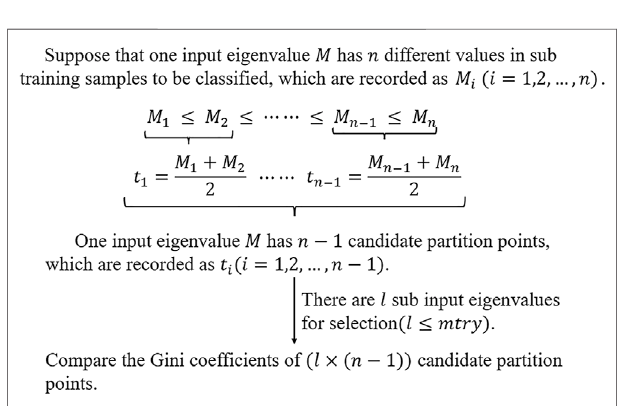
FIGURE 10 | Flow diagram of discretized continuous eigenvalues by dichotomy.